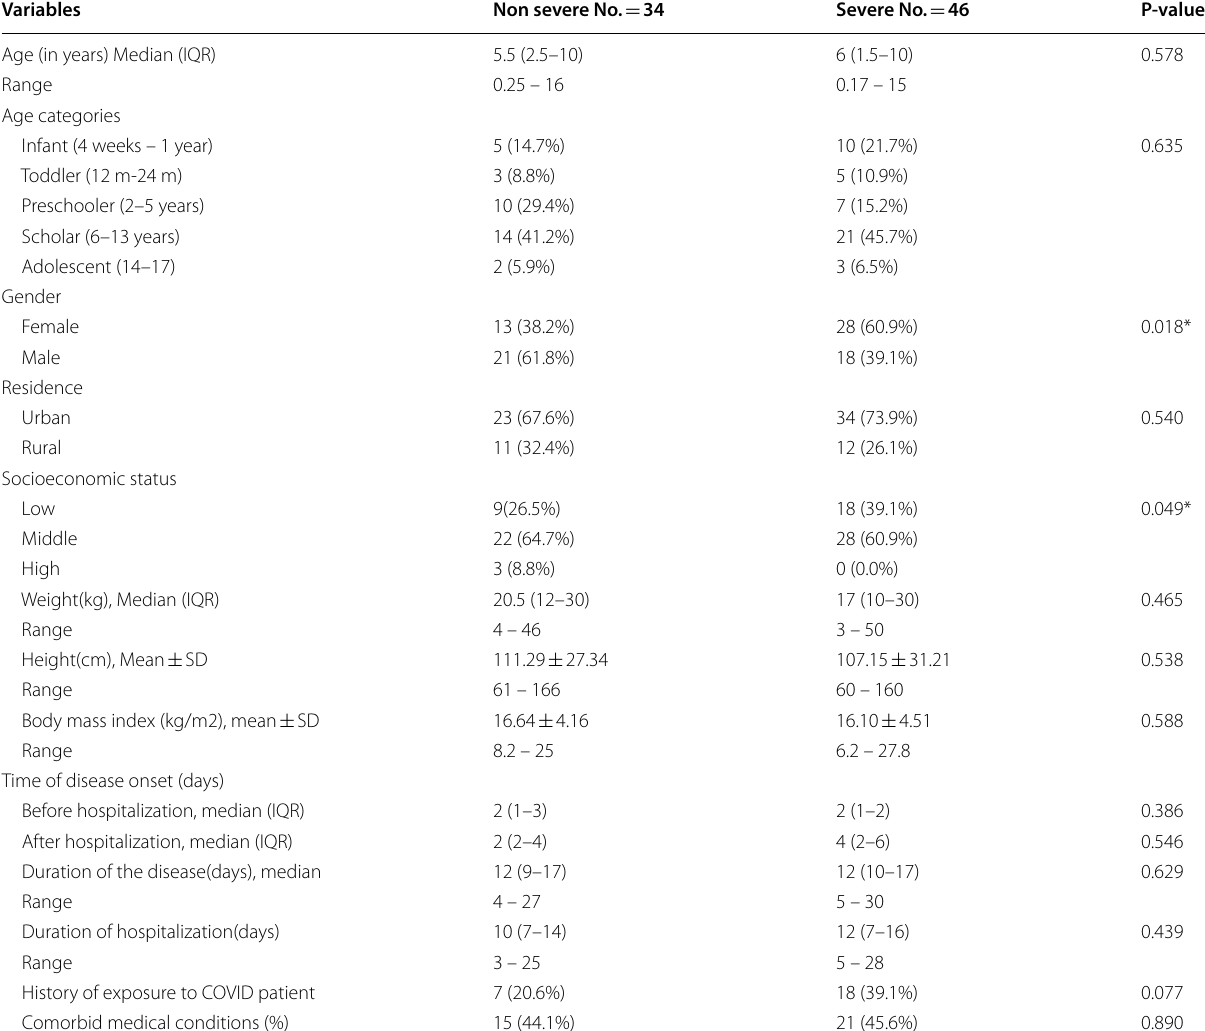
Table 1 Demographics and basic characteristics among the studied patient